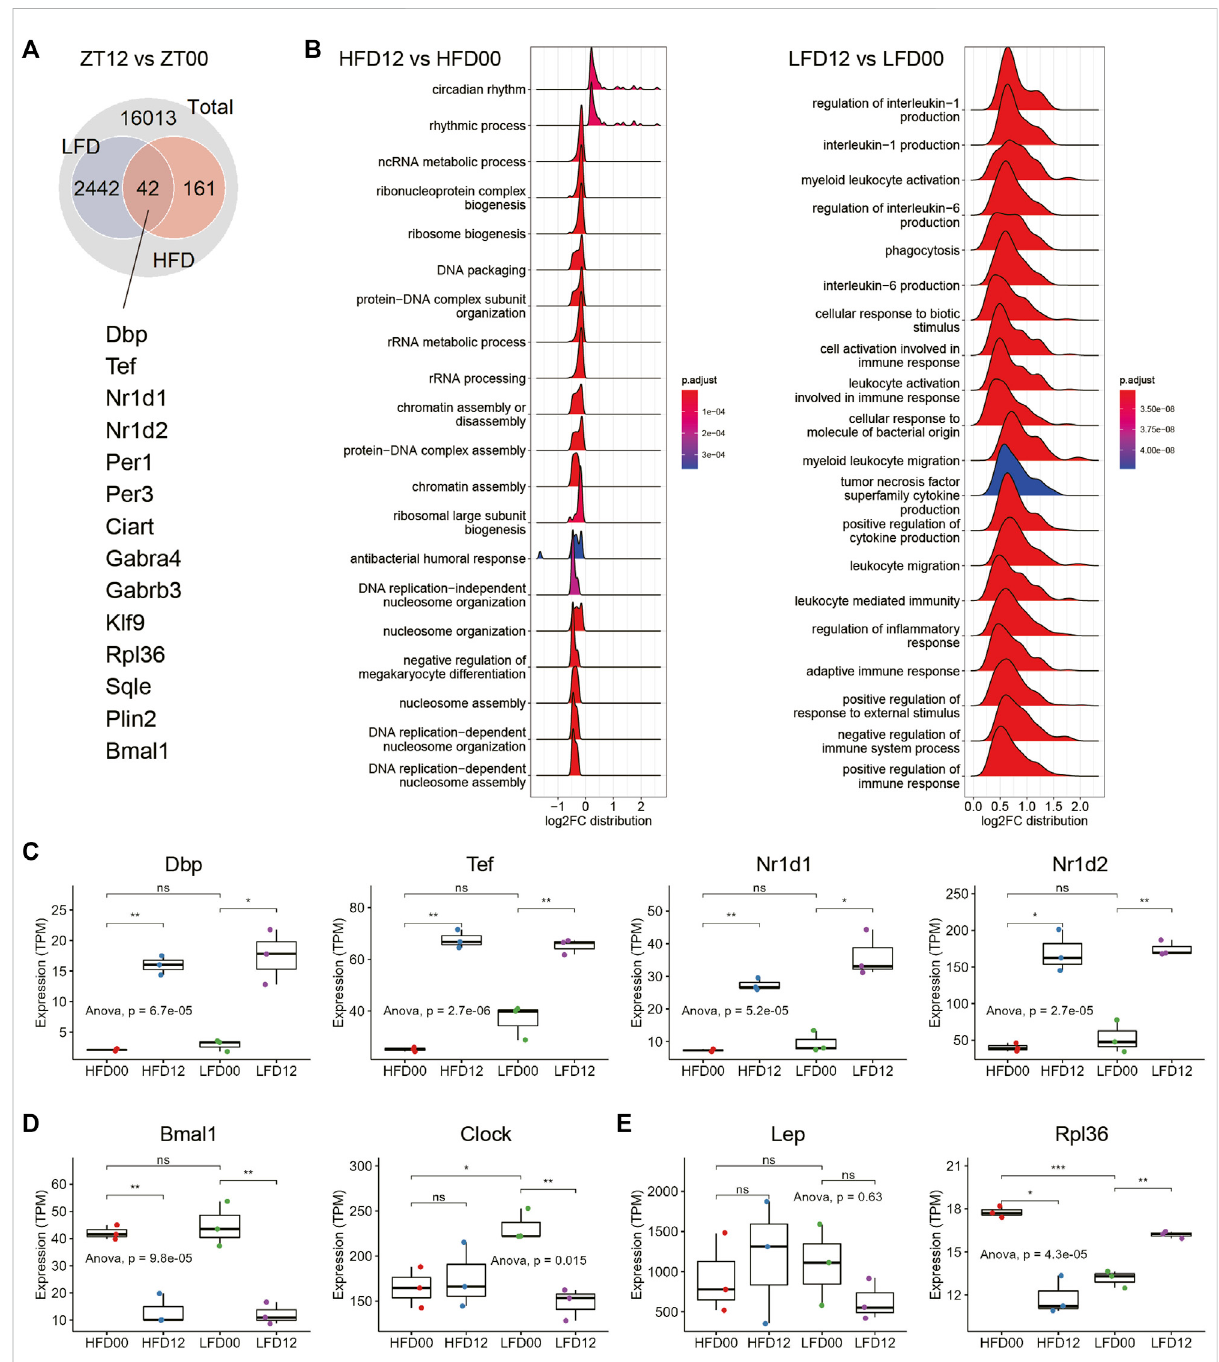
FIGURE 2 Effects of high-fat diet and diet reversal on the diurnal transcriptome in adipose tissue. (A) Interaction of DEGs between LFD12-vs-LFD00 and HFD12-vs-HFD00. (B) Ridge plots showing the results of gene set enrichment analysis (GSEA) of differentially expressed genes (DEGs) between ZT12 and ZT0 in VAT of HFD (left panel) and LFD (right panel) mice. (C) Expression of representative circadian clock genes in VAT. (D) Expression of Bmal1 and Clock genesinVAT. (E) Expression ofgenesrelatedto adipokine andribosomebiogenesis.VAT,visceraladiposetissue.HFD00,HFD mouse samples collected at ZT0; HFD12, HFD samples collected at ZT12; LFD00, LFD mouse samples collected at ZT0; LFD12, LFD samples collected at ZT12. Data are represented as mean ± SEM and jittered points. One-way ANOVA and unpaired t -test, * p < 0.05, ** p <